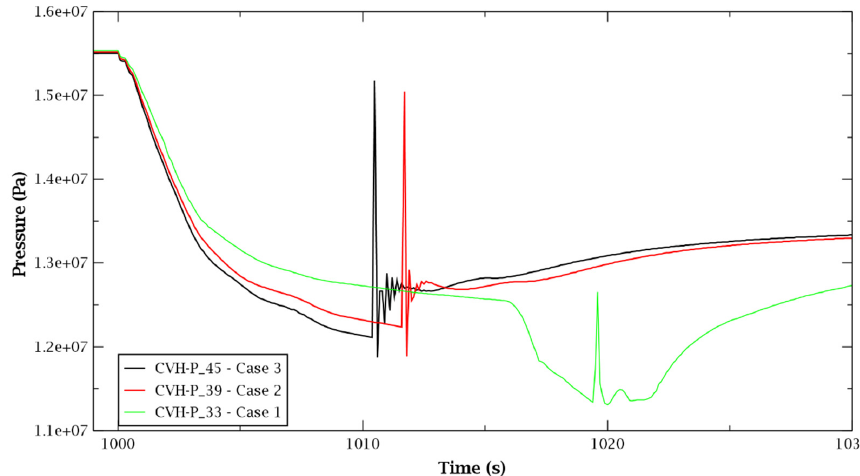
Figure 5. Pressure trend after the rupture: primary side, 1000–1030 s.